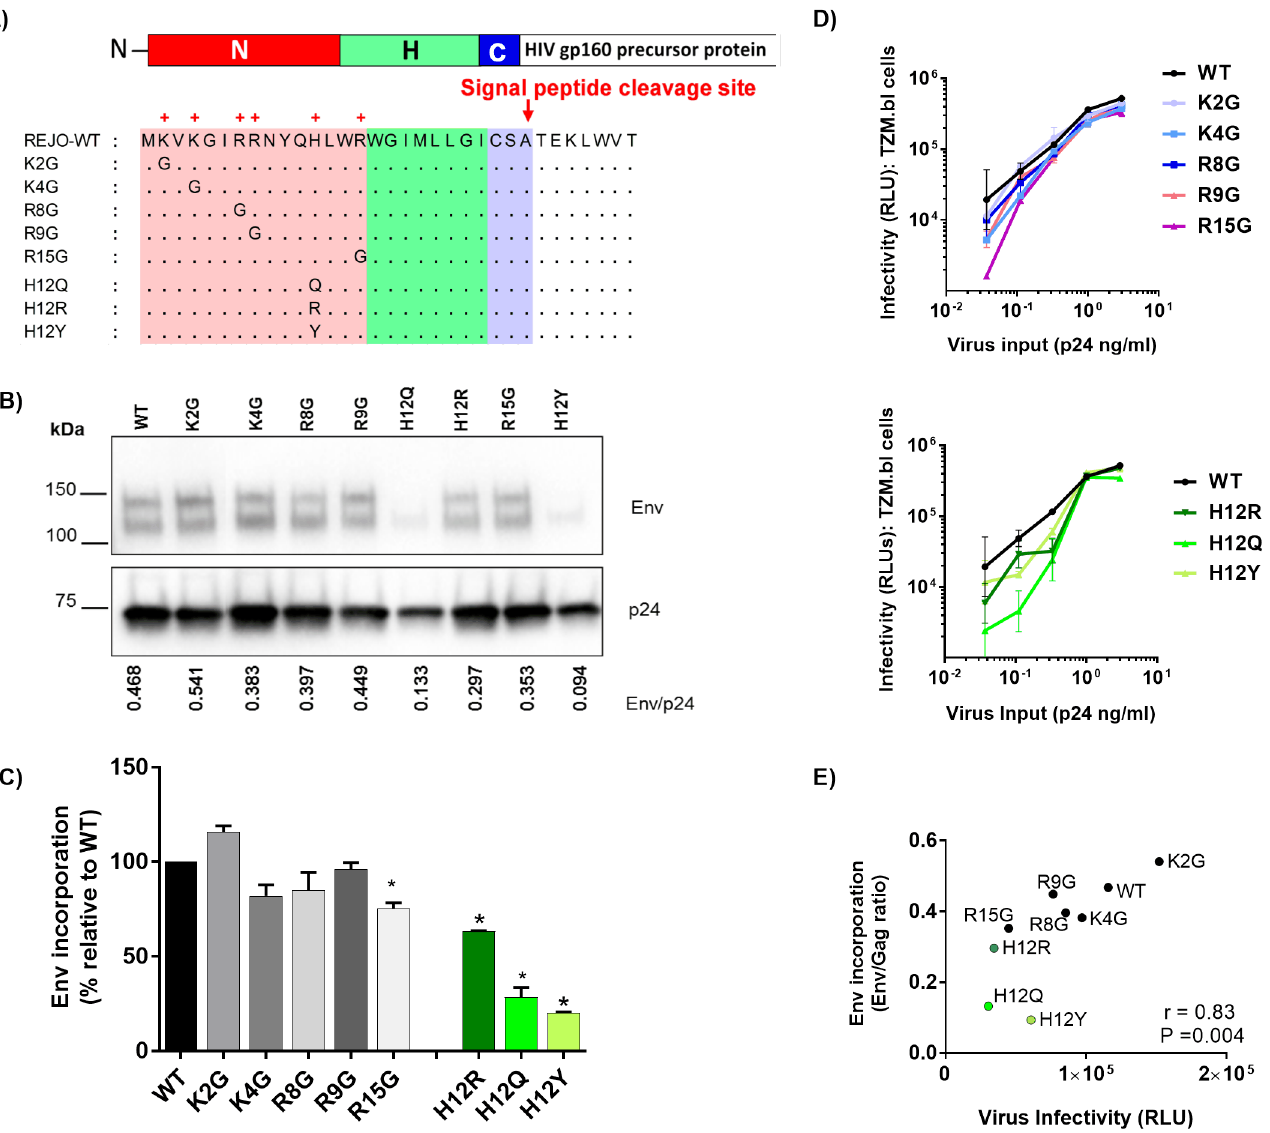
Fig 1. Effects of SP mutations on the REJO Env expression and virus infectivity. (A) Schematic representation of REJO WT and eight different SP mutations evaluated in this study. (B) Measurement of Env incorporation by Western blot. WT and mutant viruses were produced in transfected 293T cells, lysed, and analyzed by SDS-PAGE (4–20%) and Western blot. An anti-gp120 MAb cocktail (V3: 391/95-D, 694/98-D, 2219, 2558; C2: 847-D, 1006-30D; C5: 450-D, 670-D) and a p24 Gag MAb (91–5) were used to detect the relative levels of Env and Gag associated with virions. The ratios of Env/Gag were calculated. (C) The levels of Env incorporation into the mutant virions relative to that of WT were calculated based on their Env/Gag ratios (WT value was normalized to 100%). (cid:3) , p < 0.01 (ANOVA). (D) Infectivity of WT vs. mutant viruses (K/R: top; H12: bottom) in CD4+ TZM.bl cells exposed to titrated viruses with equivalent p24 contents. (E) Correlation of virus infectivity in CD4+ TZM.bl cells with the incorporation of Env into virions by Spearman’s rank test. Infectivity was based on RLU produced upon infection with a fix amount of virus input (0.33 ng p24/ml).